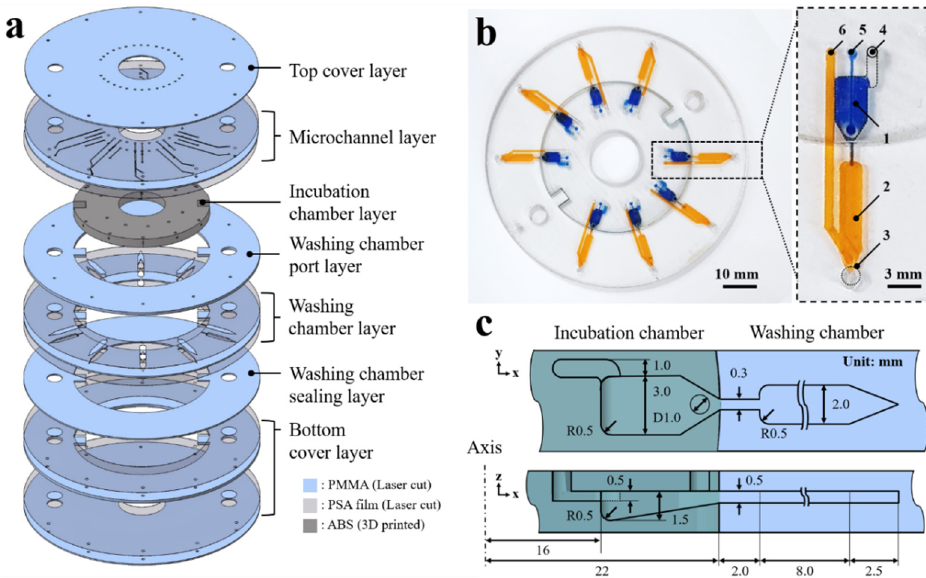
Figure 1. ( a ) Expanded view of the 3D microfluidic disk. ( b ) Image of the 3D microfluidic disk containing dyed water in the incubation (blue dye) and washing chambers (yellow dye). ( c ) Schematic of the cross-sectional illustrating the dimensions of the microfluidic chambers.